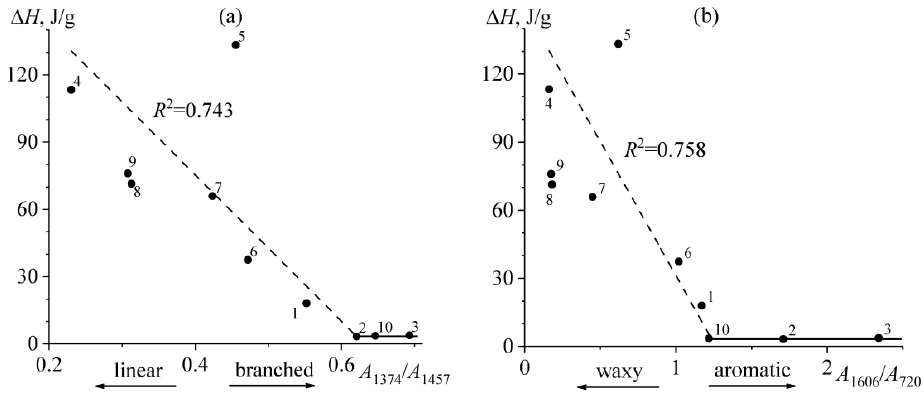
Figure 6. Dependences of the total melting enthalpy of crystallized substances of bitumens on their branchiness ( a ) and aromaticity ( b ). Bitumen numbers are indicated near the experimental points.